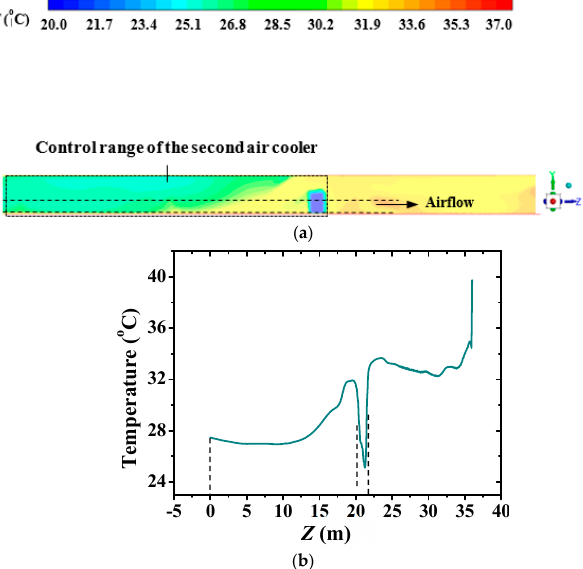
Figure 6. Temperature distribution of airflow in the cooling region for the heading face when the worker was located in the control range of the first tracking air cooler with forced ventilation: ( a ) temperature contour at the plane of X = 1.25 m; ( b ) variation of the temperature with the Z axis at the line of X = 1.25 m, Y = 1.5 m.